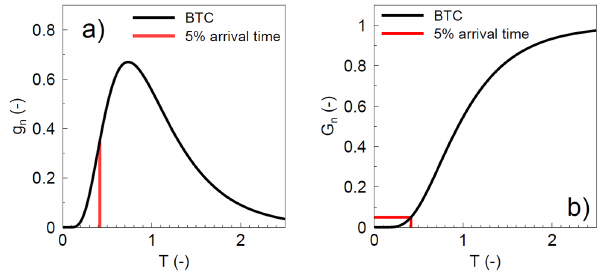
Figure 1. Illustration of the normalised 5% arrival time, p 0 . 05 . (a) shows the travel-time probability density function, g n , where the area to the left of the 5% arrival time equals 5% of the total area under the curve and (b) shows the corresponding cumulative distribution function of the travel times, G n . Both curves are plot- ted against the number of effective pore volumes drained ( T